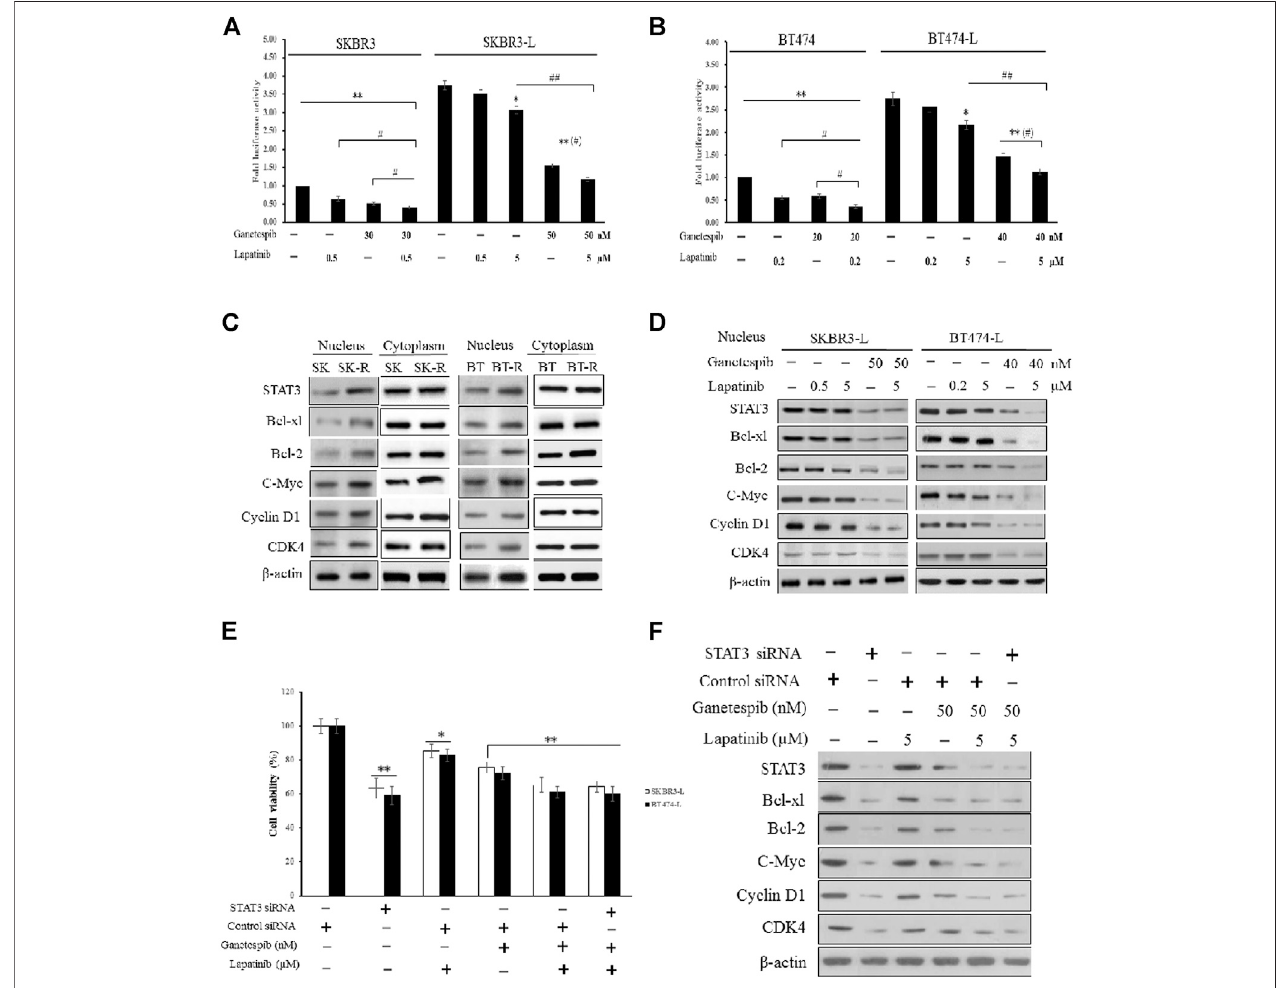
FIGURE 4 | Suppression of STAT3-mediated pathways and reversion of lapatinib resistance by combination treatment with ganetespib and lapatinib. (A) SKBR3, SKBR3-L, (B) BT474, and BT474-L were transfected using the chromosomally integrated luciferase reporter plasmid STAT3-TAL-Luc. Cells were treated with ganetespib, lapatinib or both for 24 h. Fire fl y luciferase activity was measured by Varioskan Flash (Thermo Scienti fi c). Results are shown as the mean fold induction over the activity in untreated cells. Data shown are representative of mean ± SD of three independent experiments. * p < 0.05, ** p < 0.01 vs . control by ANOVA. (C) CytoplasmicandnuclearexpressionofSTAT3,Bcl-xl,Bcl-2,C-Myc,CyclinD1,CDK4bywesternblot,using β -actinasloadingcontrol. (D) SKBR3-LandBT474-Lcells were treated with ganetespib, lapatinib or combination for 24 h, and STAT3-mediated nuclear signaling proteins were detected via western blot. (E) SKBR3-L and BT474-L cells were treated with STAT3 siRNA or control siRNA, then incubated with ganetespib, lapatinib or both for 48 h to test cell viability. * p < 0.05, ** p < 0.01 vs . control siRNA transfected cells by ANOVA. (F) SKBR3-L cells transfected with STAT3 siRNA or control siRNA and treated with ganetespib, lapatinib or combination for 24 h. Nuclear fractions were analyzed via western blot using antibodies against STAT3, Bcl-xl, Bcl-2, C-Myc, Cyclin D1, and CDK4.